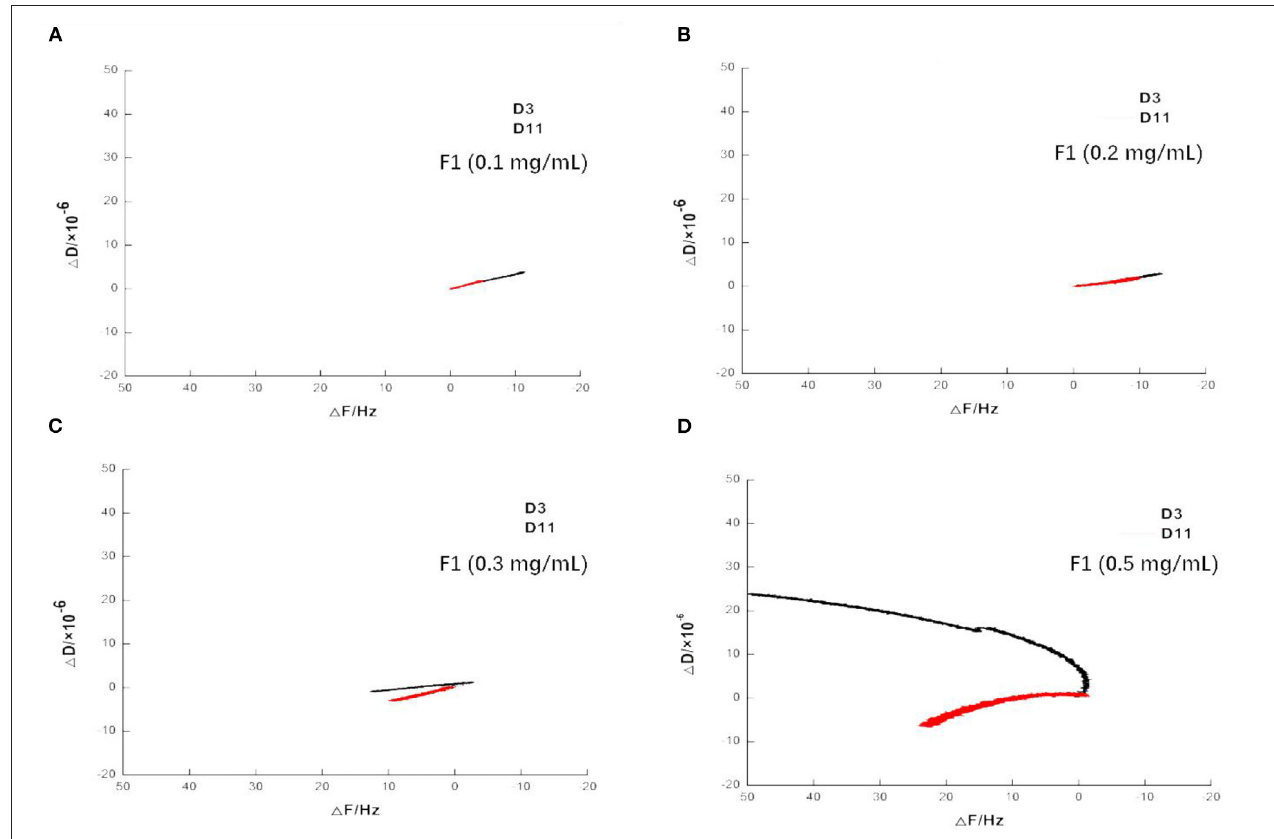
FIGURE 7 | Variation of dissipation on spreading phospholipid membrane at frequency of 3 and 11 times after applying antimicrobial peptide F1. Different concentrations of antimicrobial peptide F1: (A) 0.1 mg/mL, (B) 0.2 mg/mL, (C) 0.3 mg/mL, and (D) 0.5